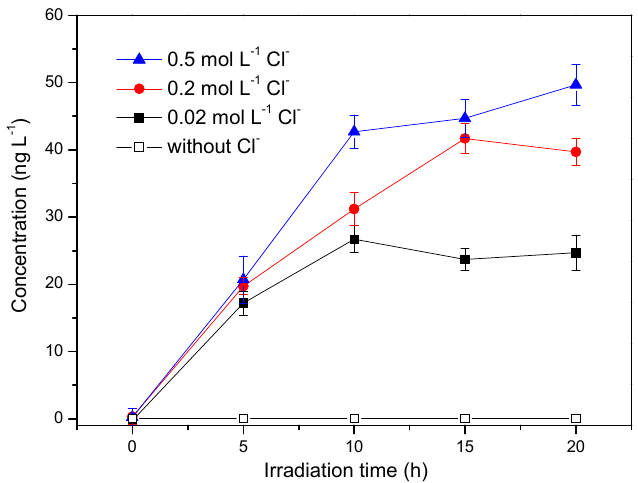
Figure 4. E ff ect of chloride ion concentration on the production of methyl chloride. Reaction conditions: Light intensity = 12 mW cm − 2 , [HA] = 5 mg L − 1 , pH = 6.5.